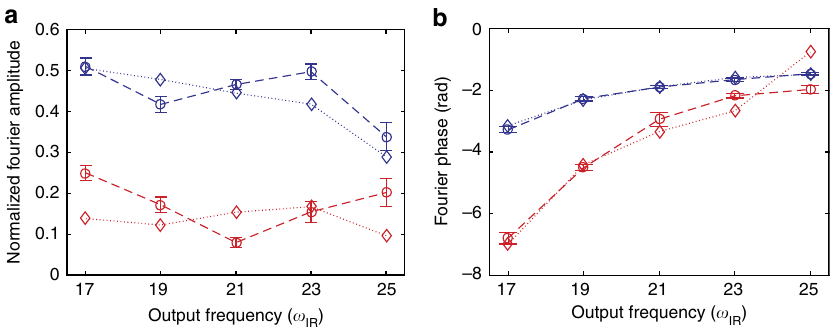
Fig. 7 Comparison of experimental and reconstructed Fourier data. a Normalized Fourier amplitudes as a function of output harmonic frequency and Fourier frequency (circles and dashed lines: experiment, diamonds and dotted lines: theory reconstruction, error bars on experimental data: standard deviation). b Like a , but showing the Fourier